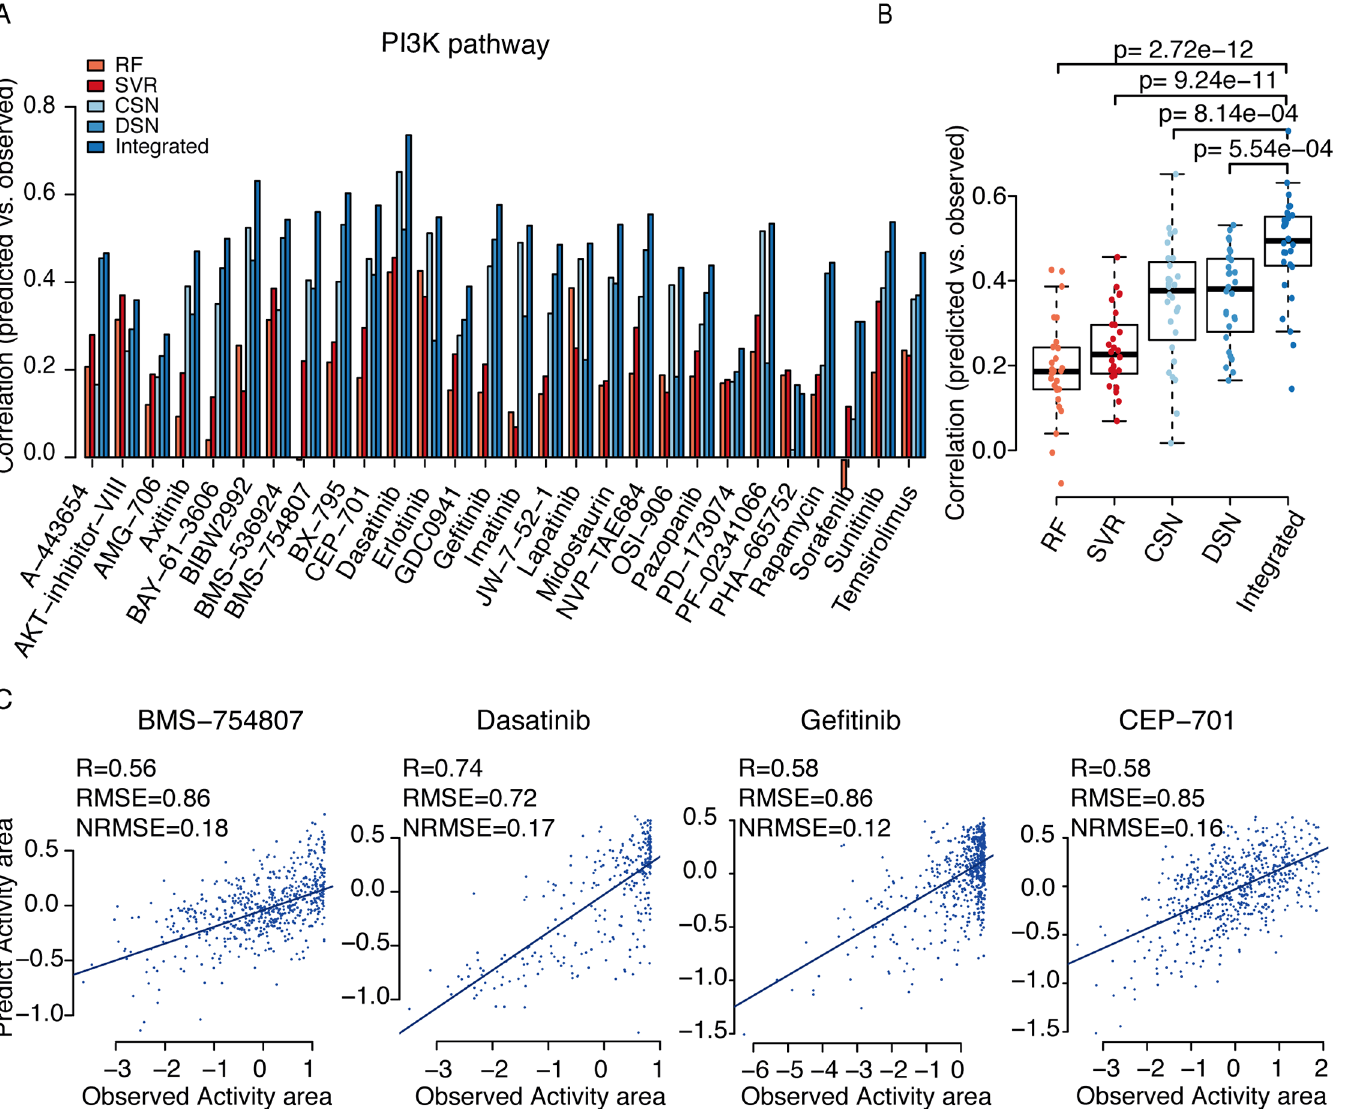
Fig 5. Prediction performance of the dual-layer network model for drugs targeting the PI3K pathway in CGP. ( A) Bar graph showing the prediction performance of five models using experimental data from the CGP study, which was quantified using the Pearson correlation between predicted and observed activity areas. RF: prediction result by random forest using combined features of genomic and chemical data; SVR: prediction result by support vector regression using combined features of genomic and chemical data; CSN: prediction results using only the cell line similarity network; DSN: prediction results using only the drug similarity network; Integrated: prediction results using the dual-layer integrated cell line-drug network model. (B) Pearson correlation distribution of the five different models using t-tests to determine differences between two groups. (C) Correlations between observed and predicted activity areas using the dual-layer integrated cell line-drug network model. (S3 Fig) pathways, the dual-layer integrated cell line-drug network model gave consistently bet-